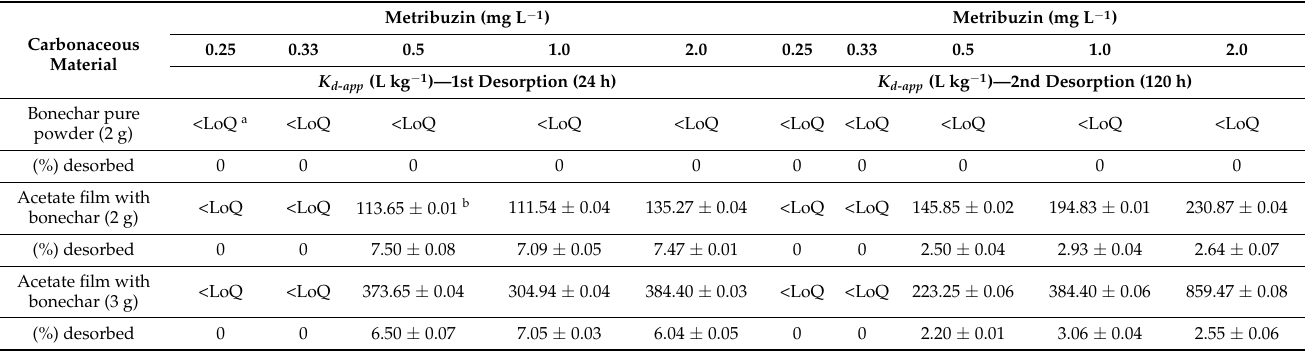
Table 5. Desorption coefficients ( K d-app ) of metribuzin on pure bonechar powder and on cellulose acetate film with bonechar at 24 and 120